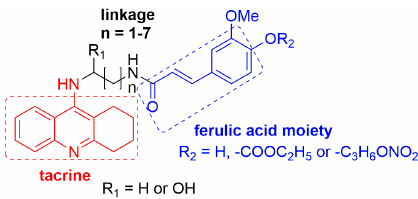
Figure 1. The synthesized tacrine-ferulic acid hybrids in the literature.